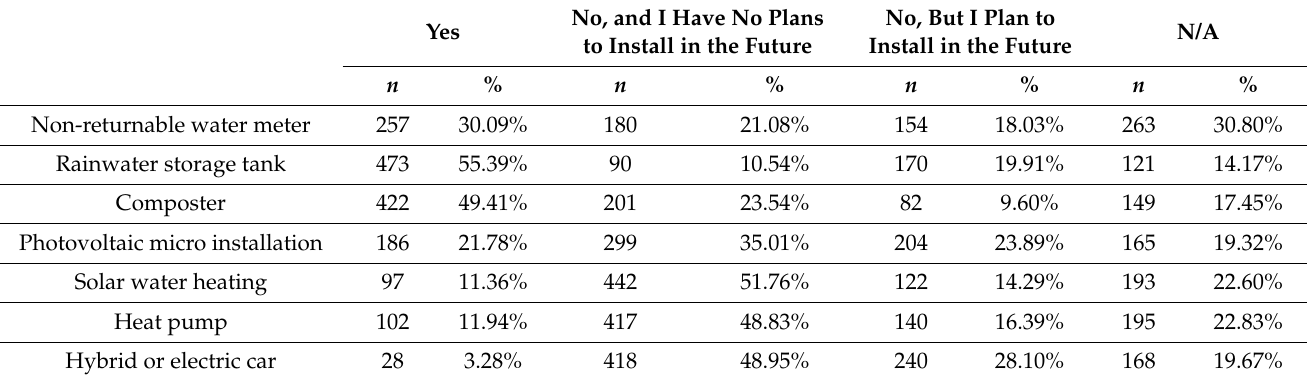
Table 3. Pro-ecological solutions owned by the